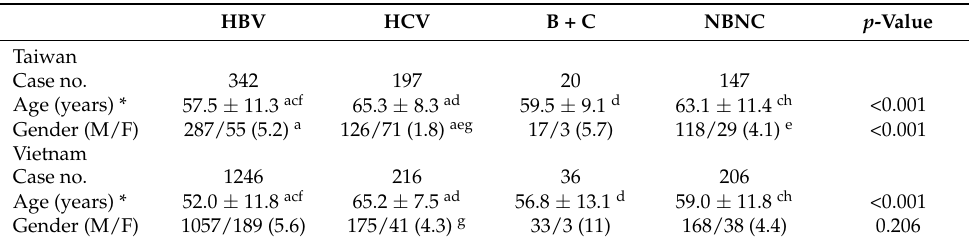
Table 2. Differences in age and gender according to viral etiology of